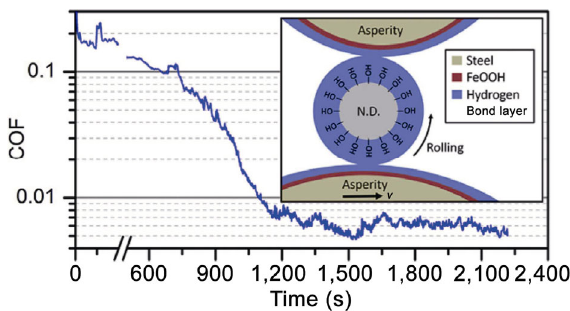
Superlubricity is achieved between steel surfaces with nanodiamonds glycerol colloid solution. Reproduced with permission from Ref. [44], © Elsevier Ltd